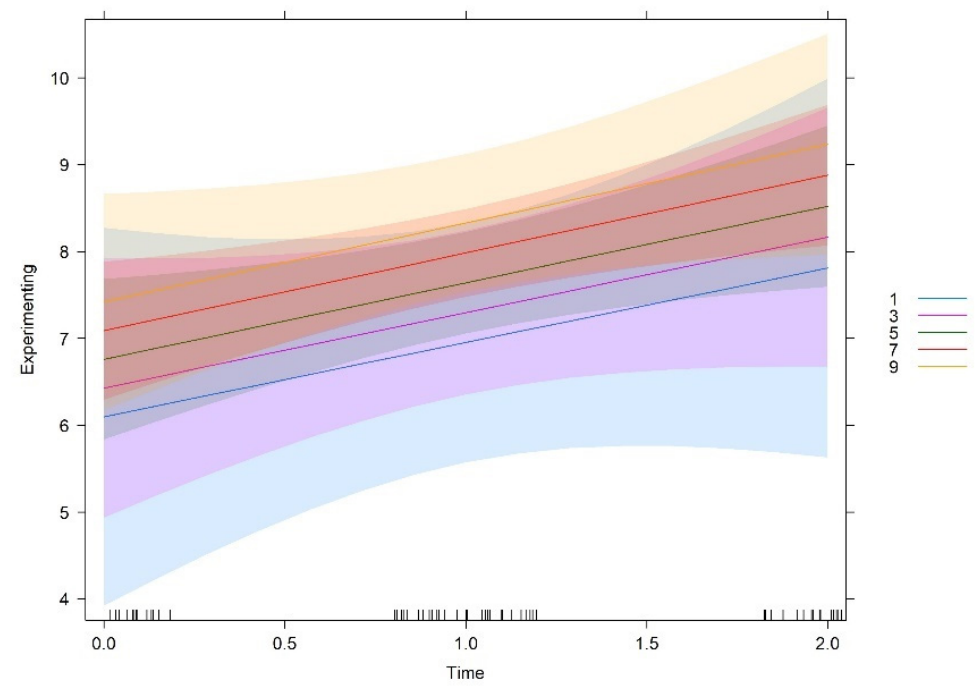
Figure 3. Interaction effect between time and rules.